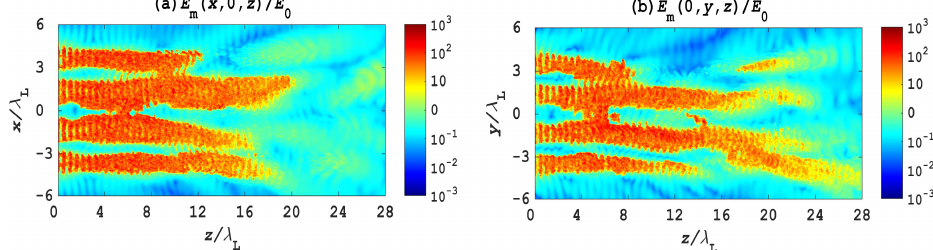
Figure 5. Simulation results for the propagation of the high-power double-ring-shaped 2 1 LG laser beam in plasma (see Video S3). The longitudinal views of the light-field magnitude of laser beam normalized to 0 E and shown in logarithmic scale ( a ) on the xOz plane and ( b ) on the yOz plane.